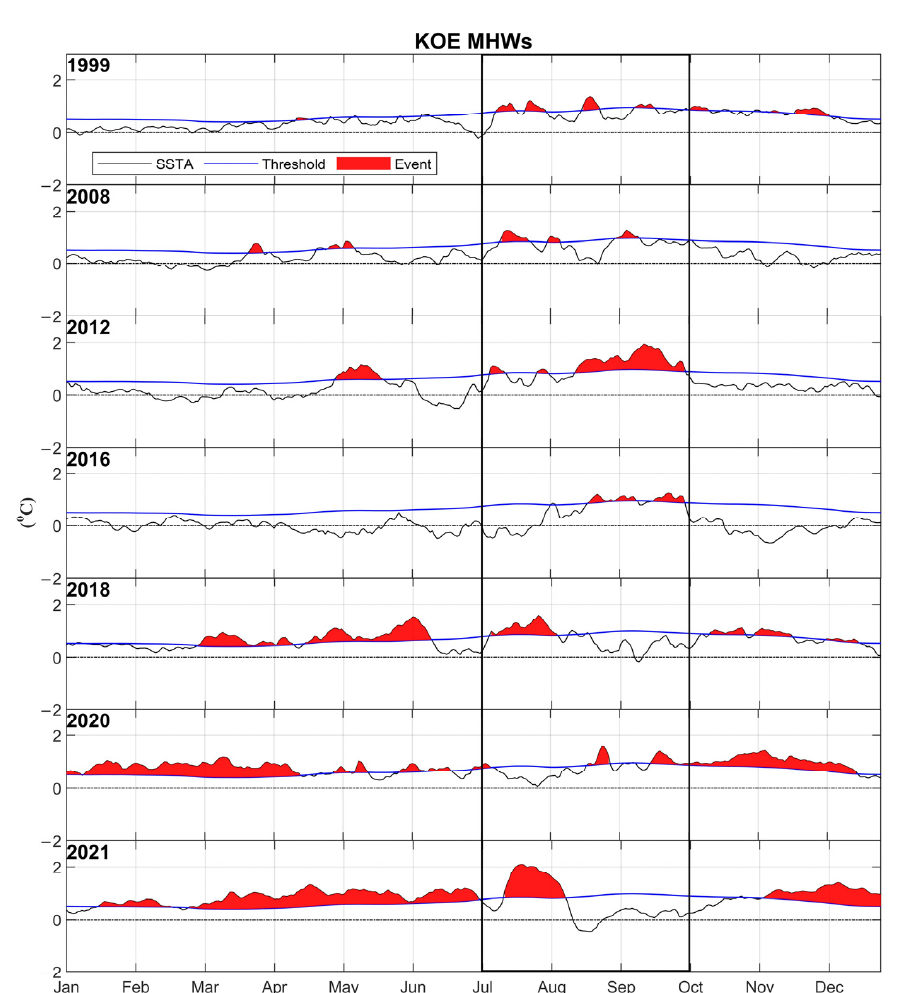
Figure 4. Times series of the SST anomalies during the seven strongest summer MHW events. The area framed by the black line represents the summer period (July-September).